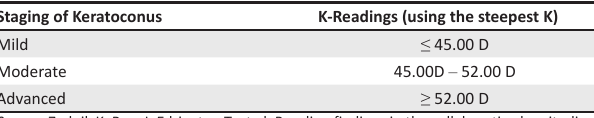
TABLE 1: Collaborative Longitudinal Evaluation of Keratoconus Study classification of keratoconus using the steepest K-reading. Staging of Keratoconus K-Readings (using the steepest K) Mild ≤ 45.00 D Moderate